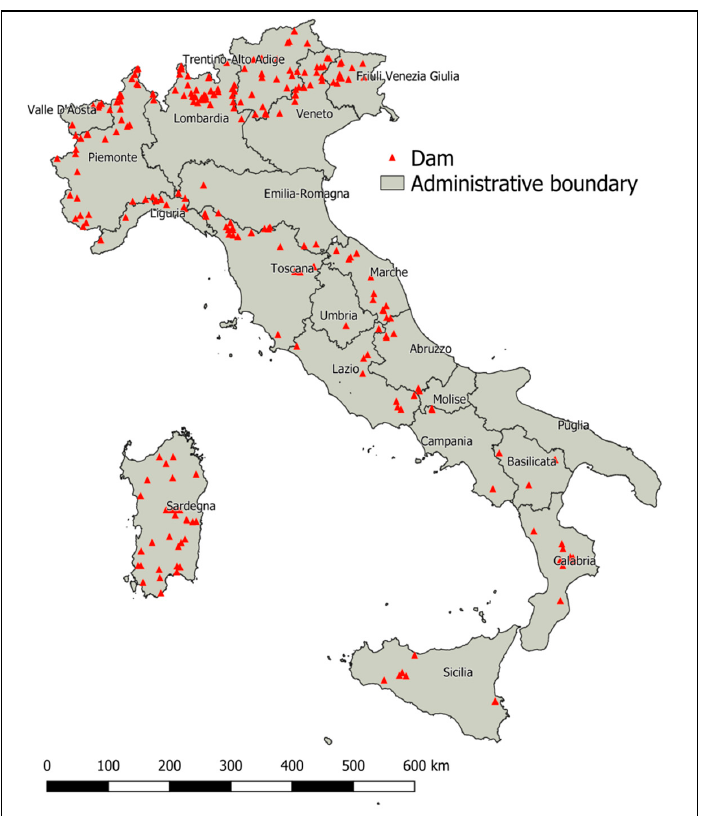
Figure 10. Overall representation of the location of the 250 Italian dams analyzed in this study.